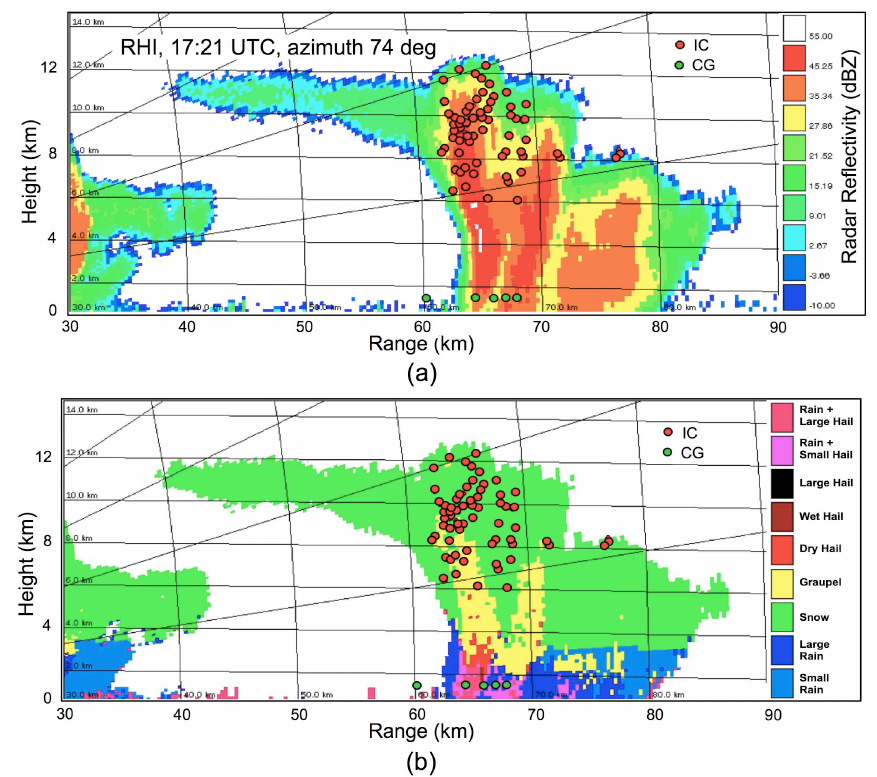
Fig. 10. POLDIRAD RHI scan of the example storm from 25 June 2008 at the time of updraft intensification at 17:20UTC with (a) the reflectivity map and (b) the respective hydrometeor classification after H¨oller et al.